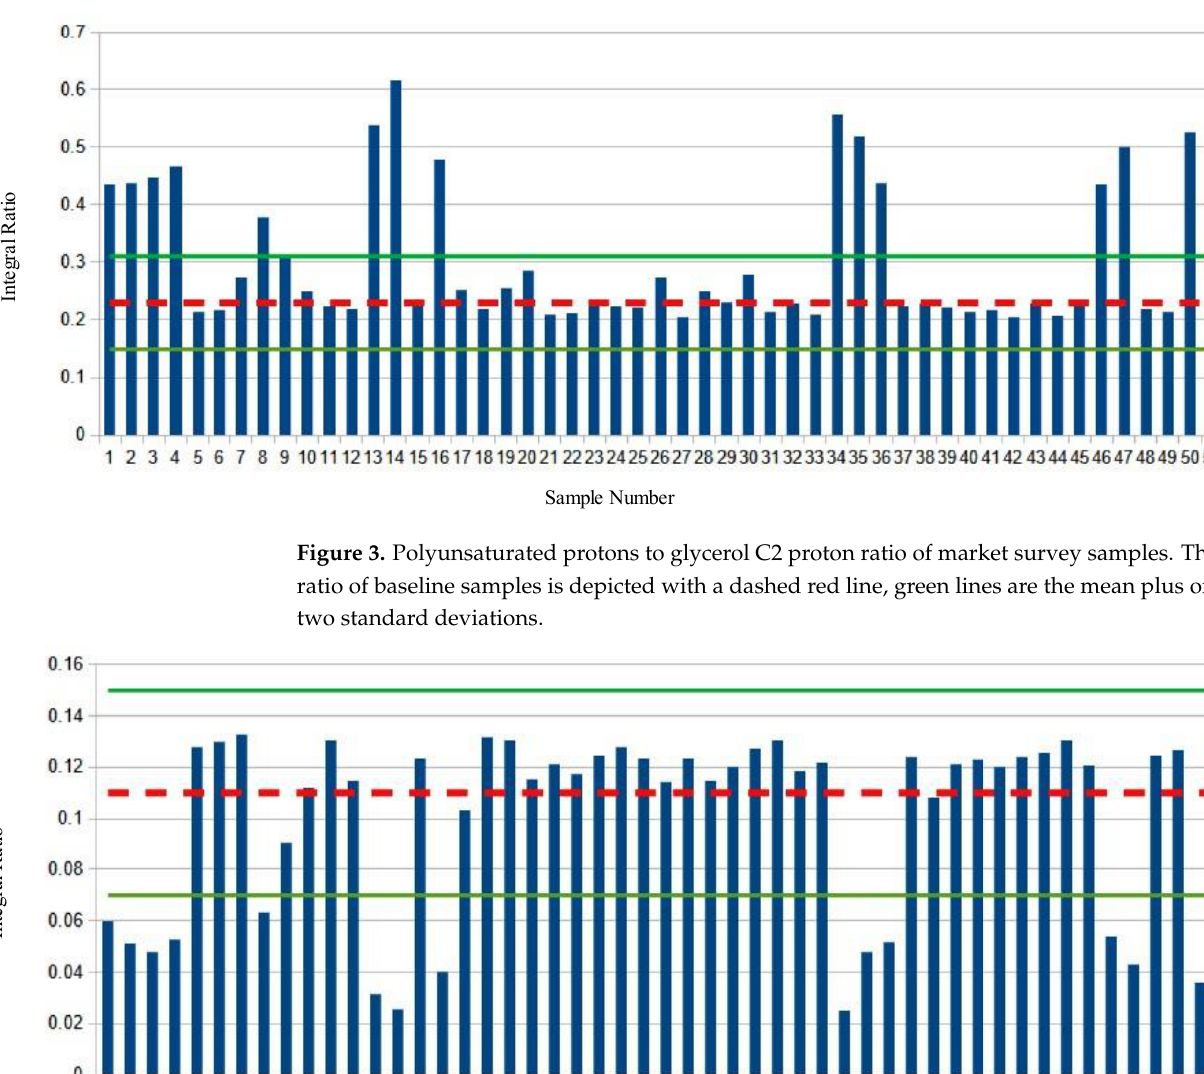
Figure 4. ω -3 Methyl to the remaining methyl protons ratio of market survey samples. The mean ratio of baseline samples is depicted with a dashed red line, green lines are the mean plus or minus two standard deviations.